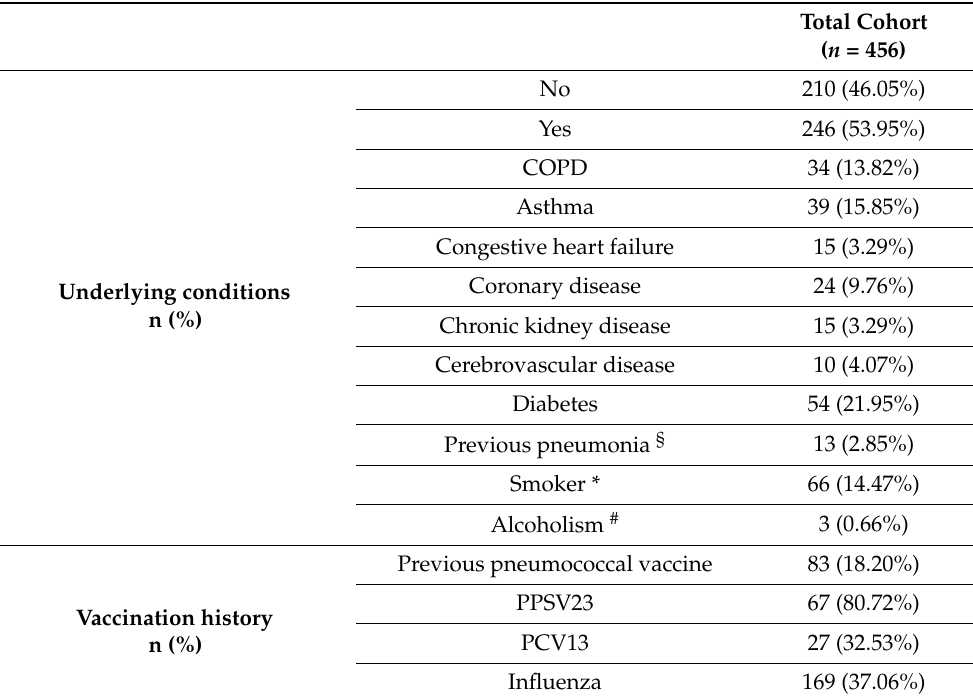
Table 3. Underlying conditions in the study population.